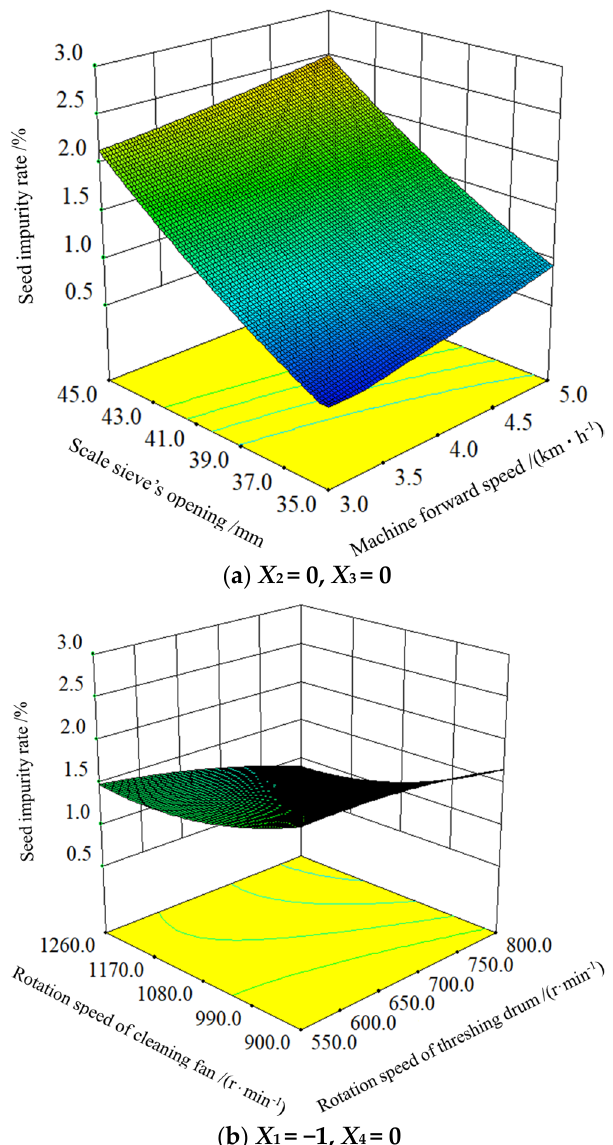
Figure 12. Response surfaces of seed impurity rate.